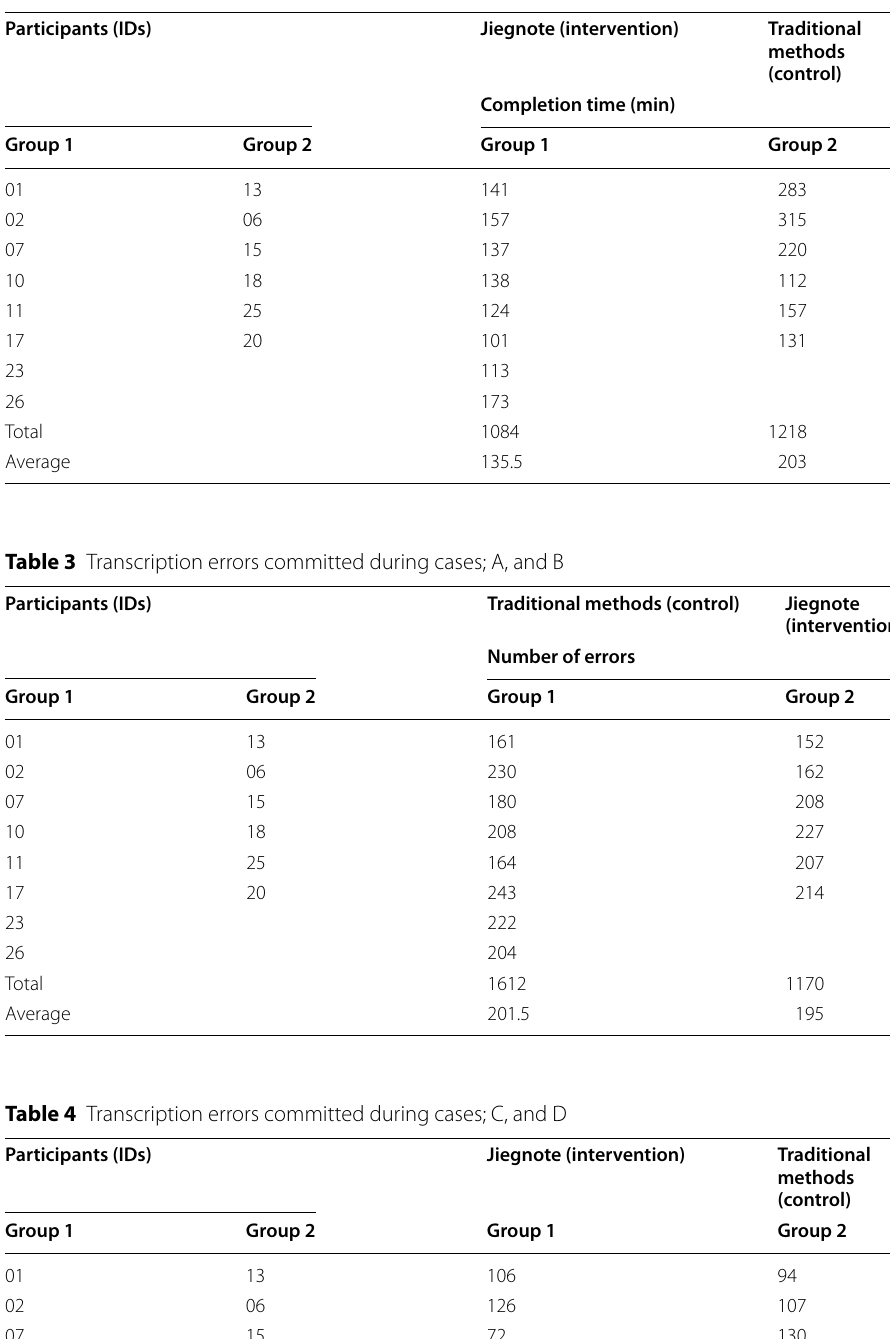
Table 2 The Transcription completion time for cases; C, and D